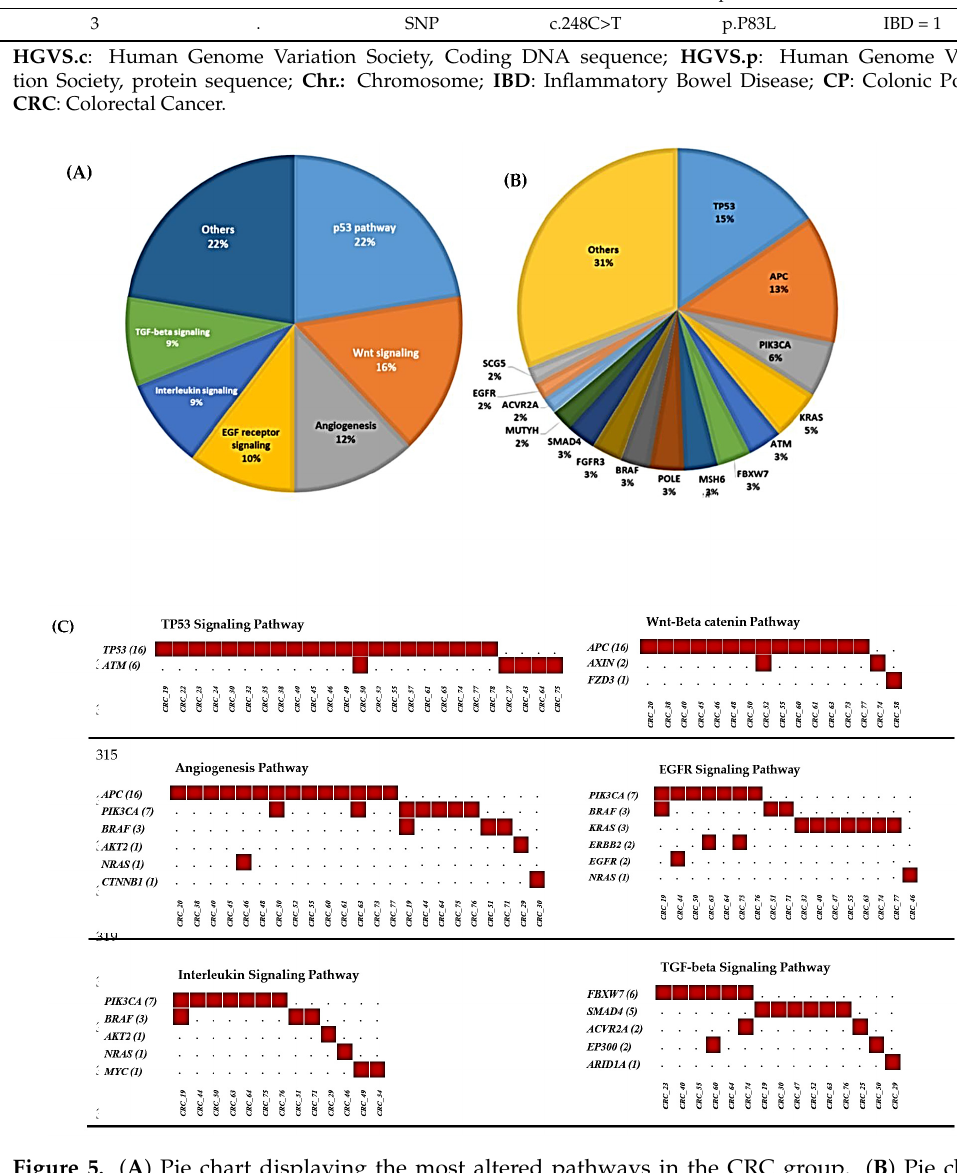
Figure 5. ( A ) Pie chart displaying the most altered pathways in the CRC group. ( B ) Pie chart displaying the distribution of mutations in the cancer driver genes. ( C ) Pathway analysis displays the somatic mutations’ distribution of the genes involved in the P53, Wnt/ β catenin, Angiogenesis, EGFR, Interleukin, and TGF- β signaling pathways; Number of red squares indicates the number of identified somatic variants per gene in the CRC patients.